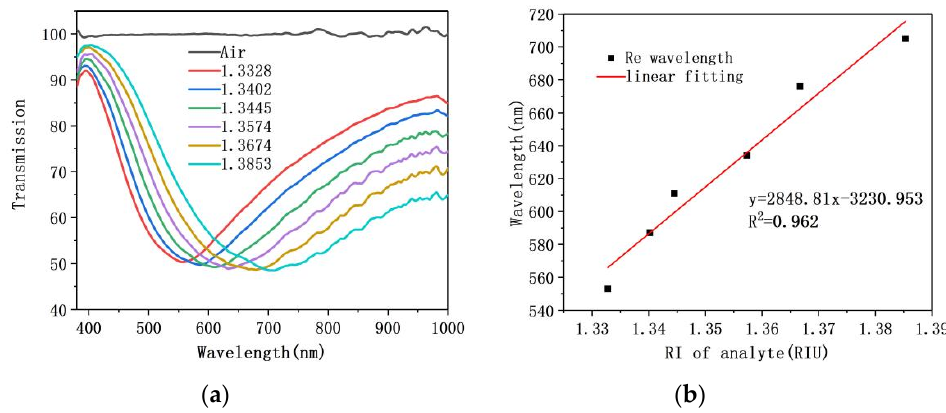
Figure 10. ( a ) Resonance spectrum of fiber/Ag film SPR sensor as the refractive index of the analyte increases; ( b ) The sensitivity fitting curve.